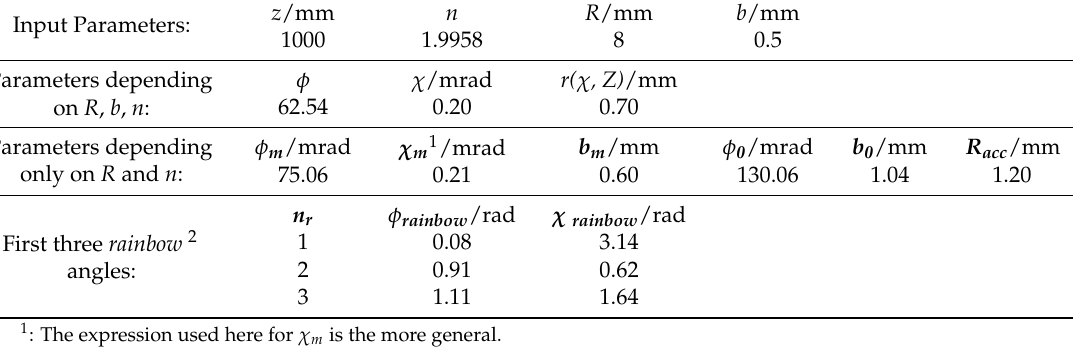
Table 2. list of main optical parameters considered in ray tracing